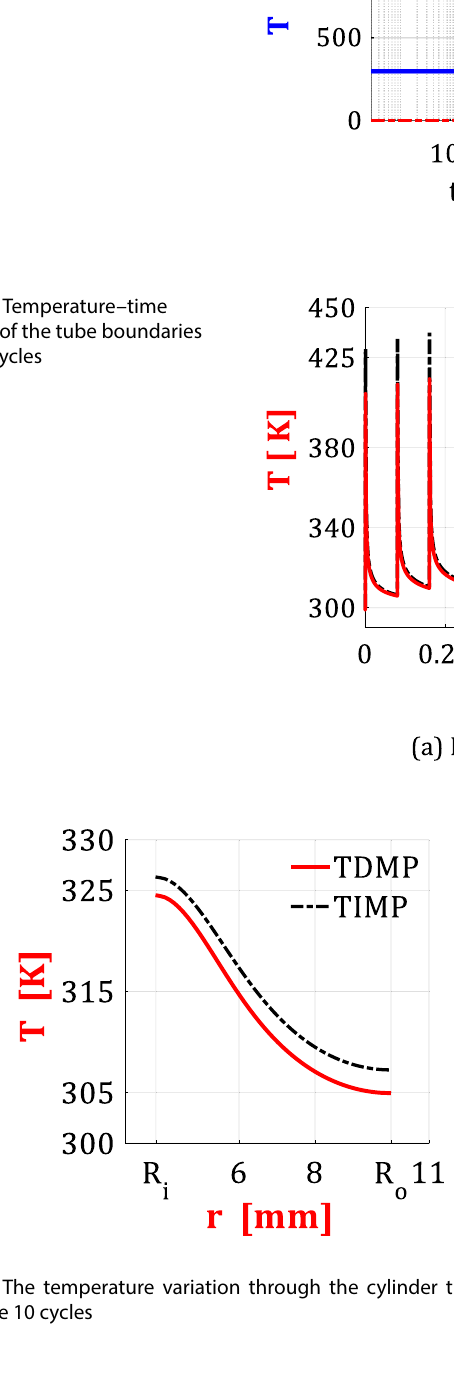
Fig. 10 Applied thermo- mechanical loads for a com- plete cycle at the inner surface of the thick-walled cylinder, 178 mm from the load source section